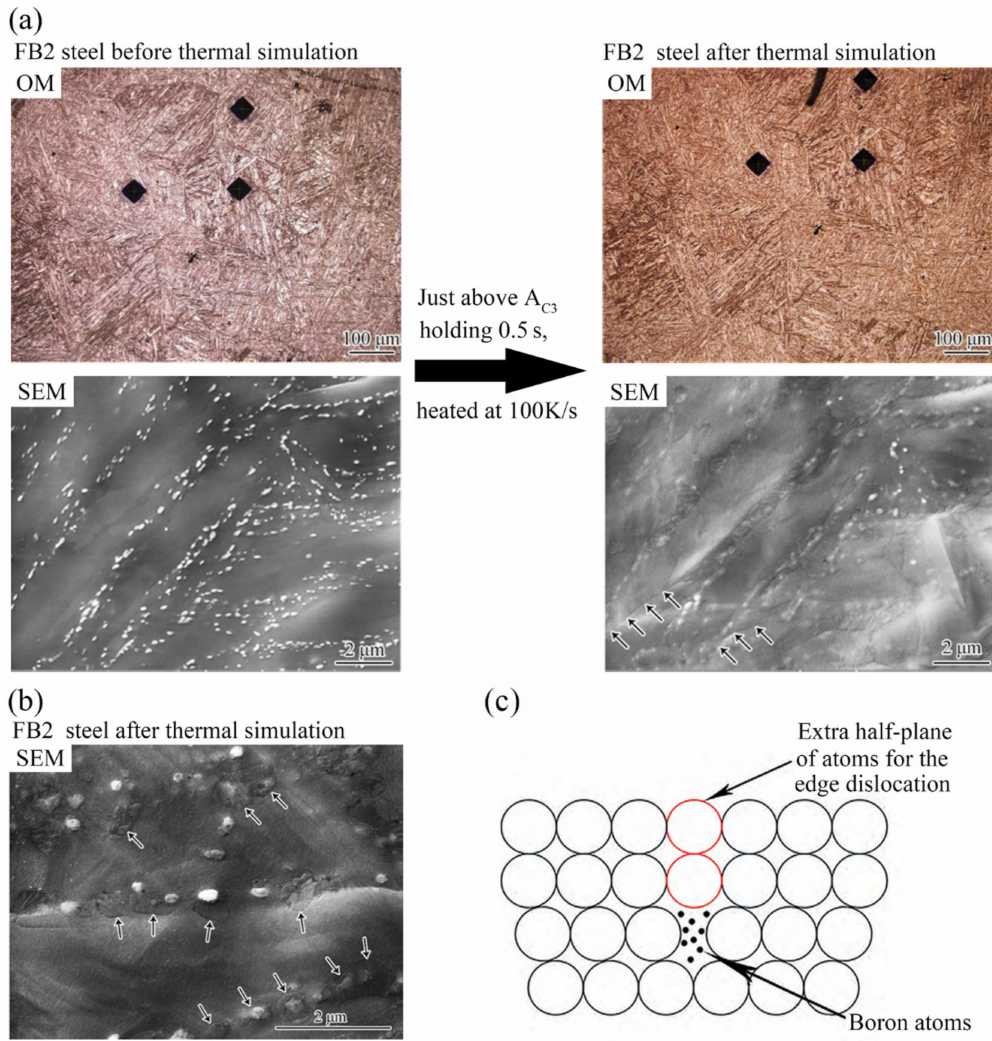
Figure 9. Austenite memory e ff ect in HAZ of FB2 steel [80]: ( a ) OM and SEM images of the same location before and after A C 3 HAZ thermal simulation (The arrows show the straight interface within martensite lath), ( b) SEM image after A C 3 HAZ thermal simulation (The arrows show the rounded interface at boundaries of prior austenite and martensite lath), and ( c ) schematic diagram for the distribution of boron atoms in the lattice under rapid